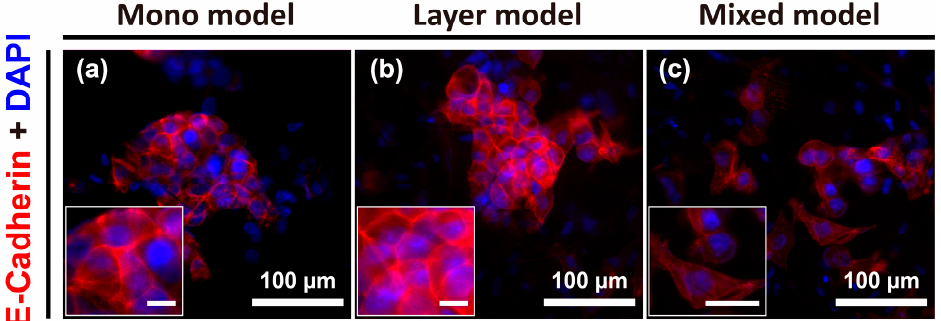
Figure 4. Images of E-cadherin expression at cell-cell junctions of Hep G2 cells under various culture conditions on day 7, which was not expressed in CCD-1112Sk fibroblasts, detected using E-cadherin antibody. Mono model ( a ); layer model ( b ); and mixed model ( c ). Unmarked scale bars, 10 μ m.